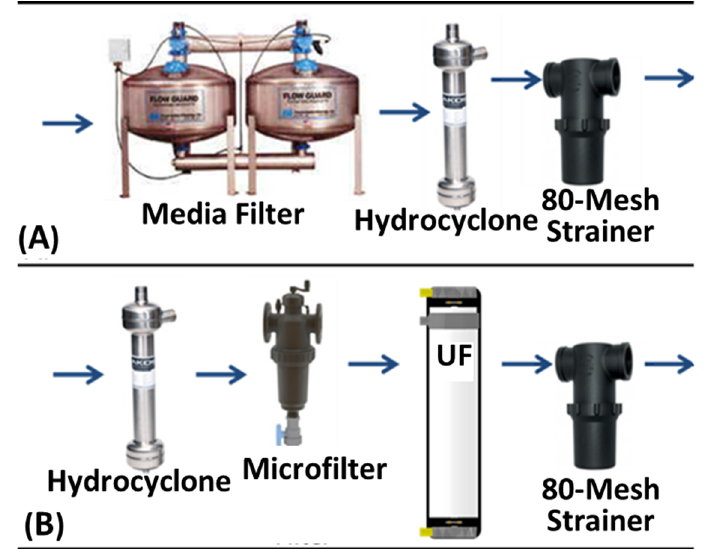
Figure 2. Schematic illustration of the sequence of two RO feed water pretreatment trains: ( A ) media filtration, followed by a hydrocyclone and 80-mesh strainer; and ( B ) hydrocyclone, followed by a 200 µm microfilter (MF), ultrafiltration (UF), and 80-mesh strainer.